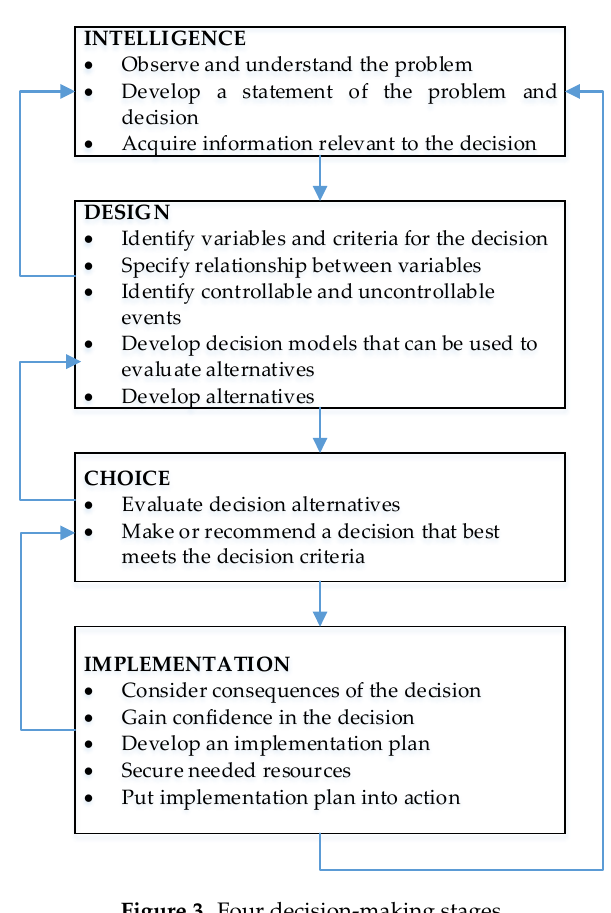
Figure 3. Four decision-making stages